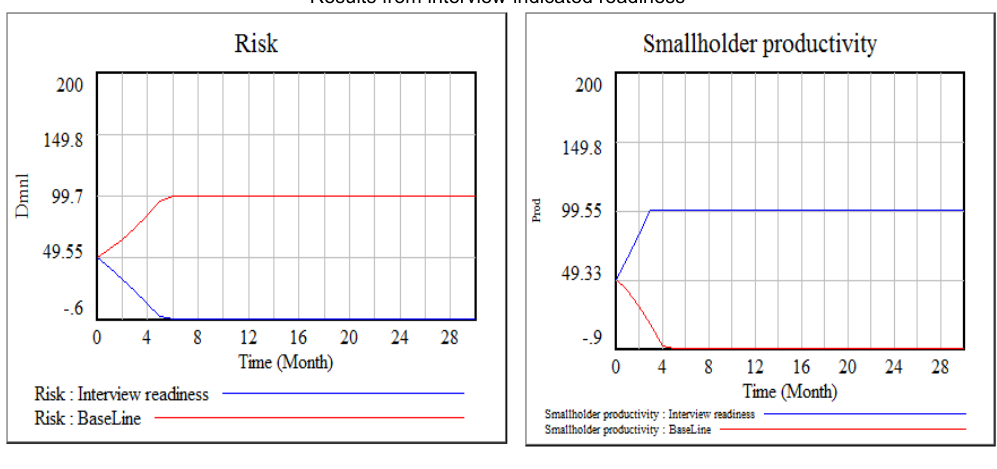
Results from interview-indicated